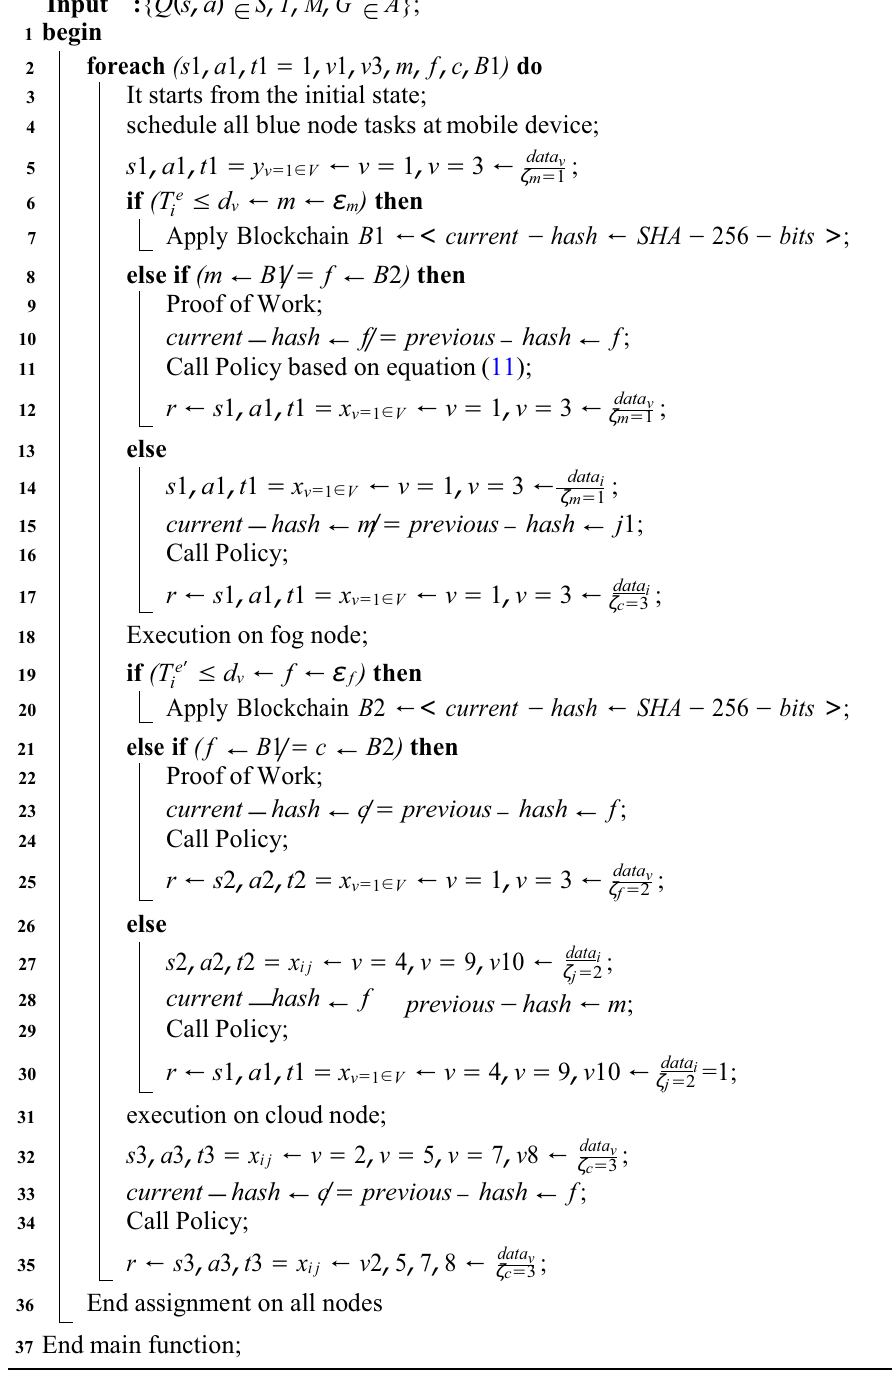
Algorithm 3: Adaptive Blockchain-Scheduling Scheme in